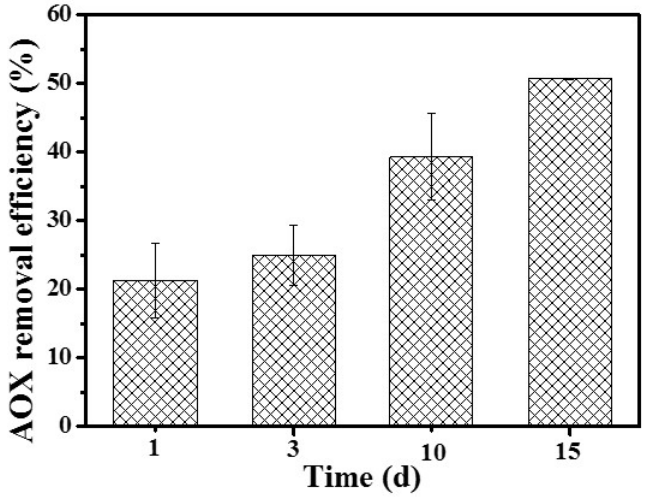
Figure 4. The effect of reaction time on the removal efficiency of AOX (Pd/Fe powder = 10 g/L, Pd loading = 0.05 wt %, pH 6.0).